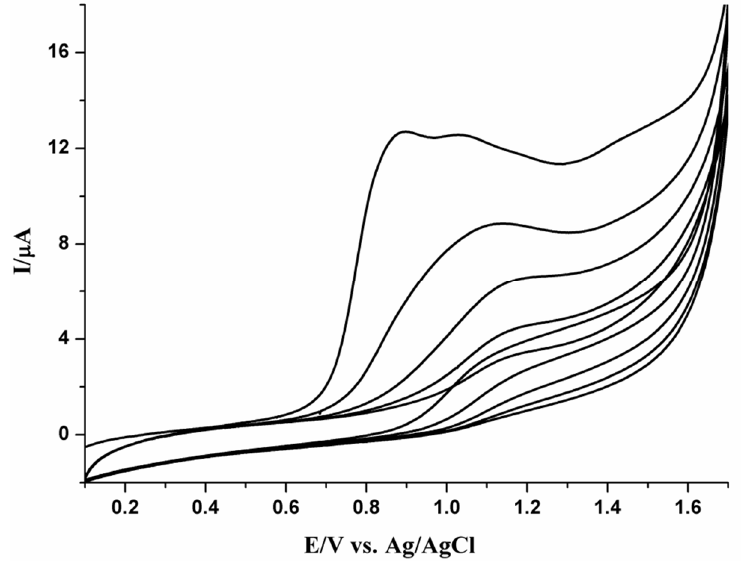
Figure 7. Cyclic voltammogram of 1.0 × 10 − 4 M pyrrole and 50 µL MWCNTs on GCE in 0.2 M H 3 PO 4 (pH 2.54) for five cycles at scan rate of 20 mV s − 1